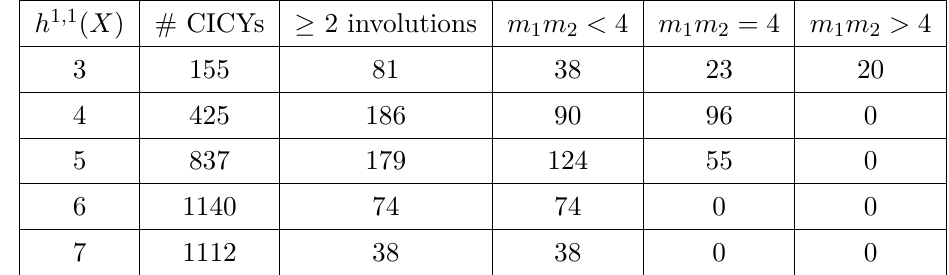
Table 2 . The number of CICYs, CICYs with at least two involutions and numbers which realize the three cases for m 1 m 2 for Picard numbers h 1 , 1 ( X ) ≤ 7